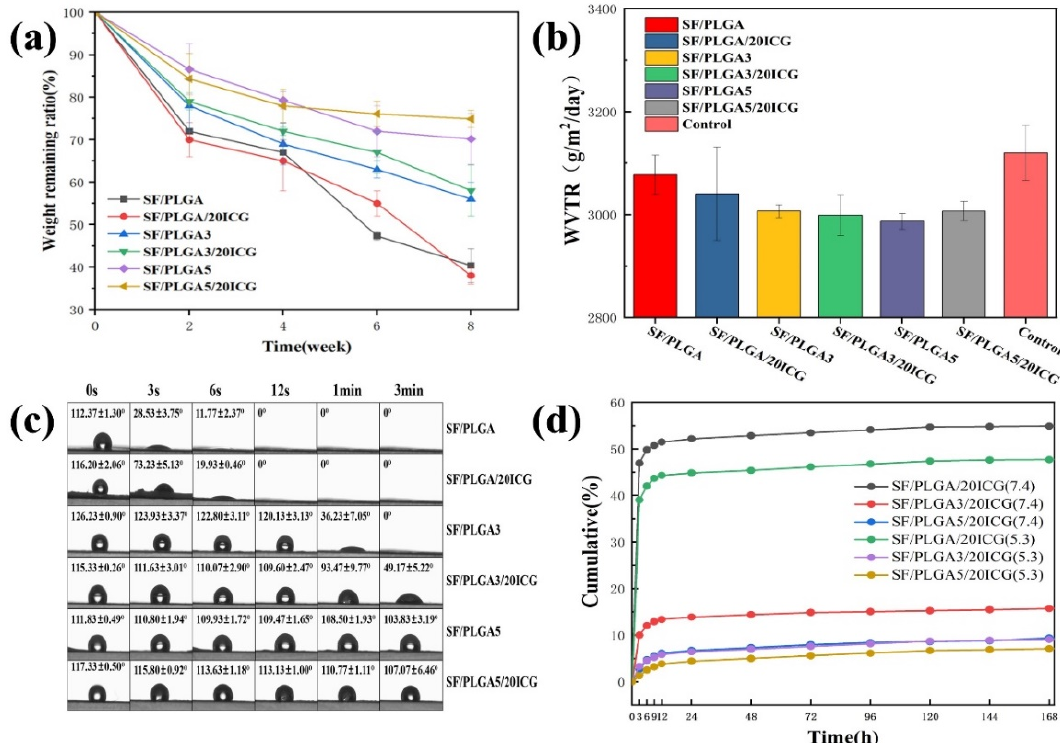
Figure 3. ( a ) Degradation profile of the nanofibrous membranes; ( b ) WVTR; ( c ) contact angle of ICG- loaded nanofibrous membranes; ( d ) cumulative release of ICG in PBS and acetic acid buffer.